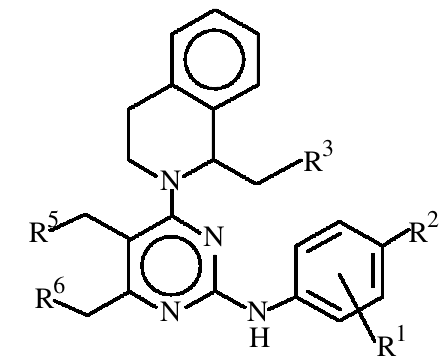
R 1 = H, Me, halo, R 2 -R 6 =H, halo Provided that when all of R 3 -R 6